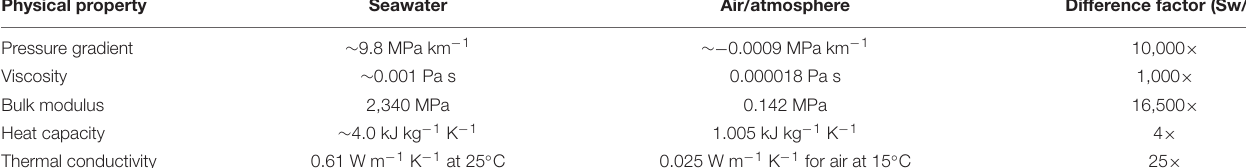
TABLE 2 | Physical properties of water and air (from Cas et al., in press).